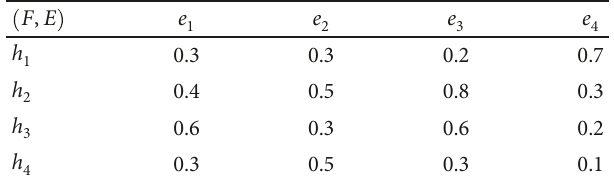
Table 1: Fuzzy soft set F , E